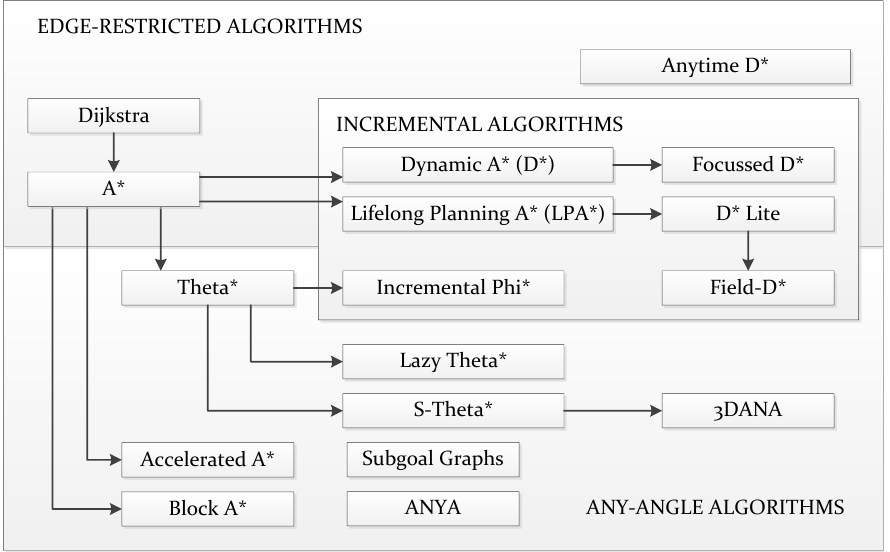
Figure 9. Overview of many different approaches to Graph Search path planning. The arrows indicate how most of them rest on older approaches yet introduce significant